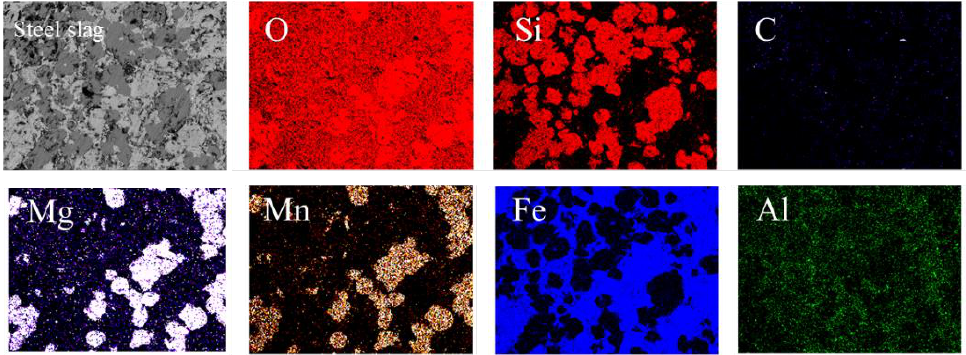
Figure 8. Elements maps of steel slag.